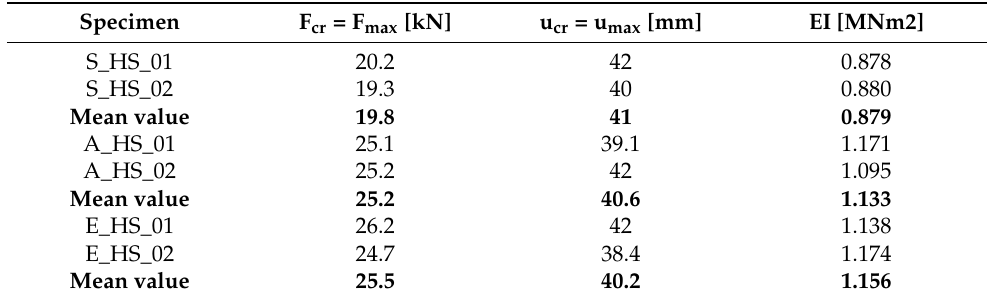
Table 10. Results of measurements TGIB-gw with heat strengthened float glass—HS (E—epoxy,